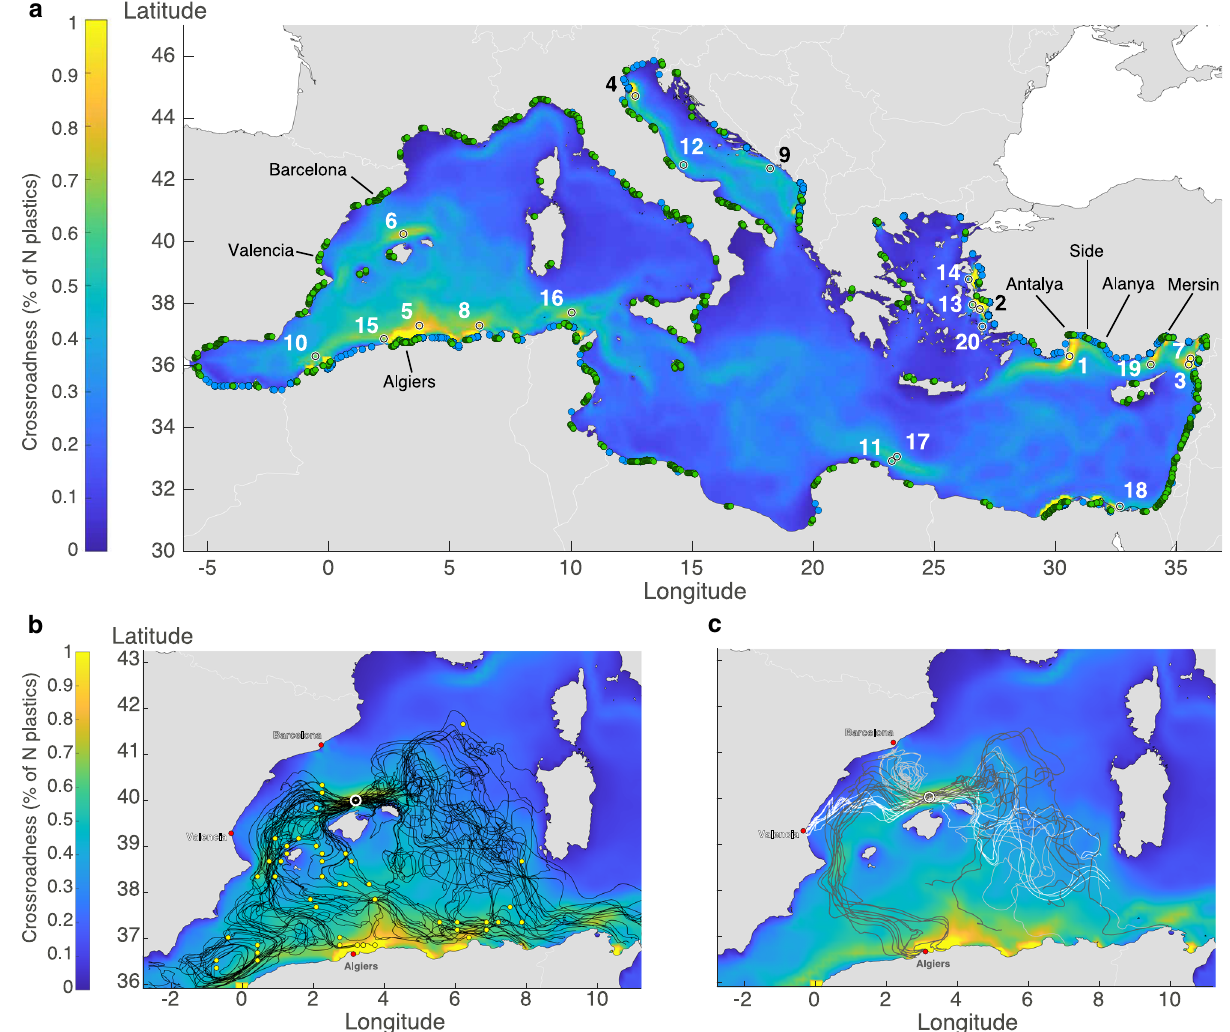
Fig. 3 Crossroadness and plastic crossroads. a Crossroadness fi eld calculated from simulated particle trajectories ( N ≃ 1.472× 10 8 ) between 2013 and 2017. White and black circles, with radius equal to σ , show the twenty most important plastic crossroads, together with their ranking. b , c Focus on the western Mediterranean basin in the region surrounding the sixth-ranked crossroad (white circle), located north of Mallorca. Trajectories of some of the particles passing through this crossroad are shown by the solid lines: ( b ) particles directly released at sea by vessels at the green dots; ( c ) particles originating from three cities: Barcelona (gray lines); Valencia (white); and Algiers